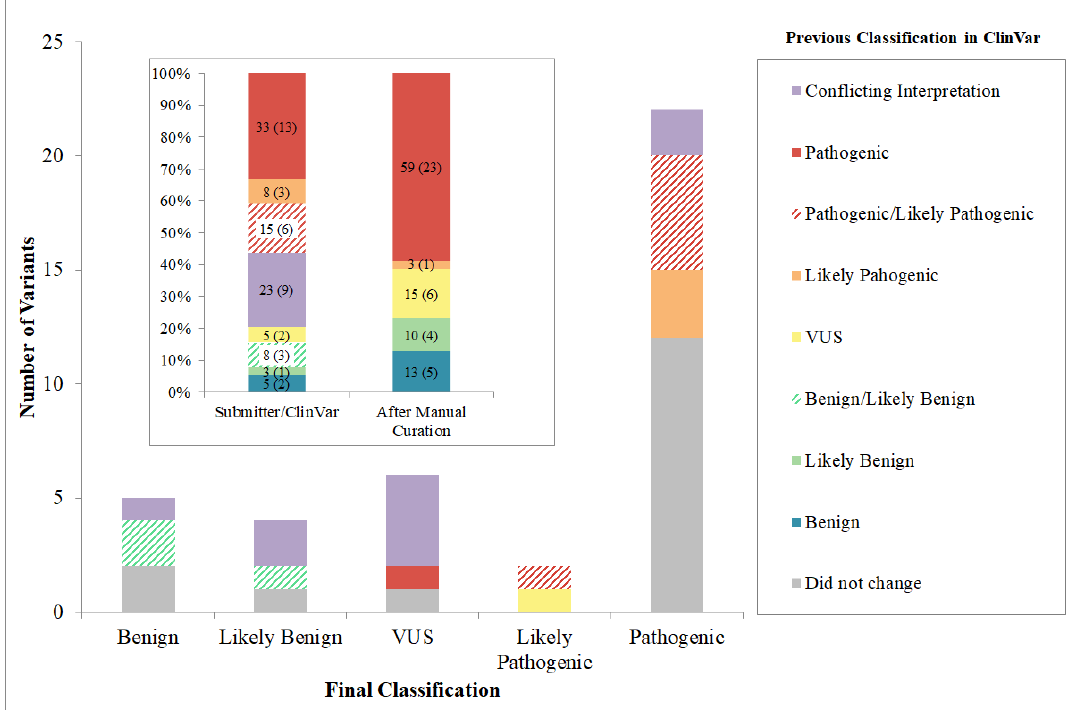
Figure 4. Final GJB 2 and GJB 6 variant classification. The height of each bar represents the number of variants for each classification. The colored segments of each bar represent previous classification in ClinVar. As a result of the curation process 59% of sequence variants changed their previous category submitted to ClinVar. The inner box shows the comparison of the 44 variant classifications between ClinVar submitters (from the original ACMG/AMP criteria) versus applying HL-EP specifications, demonstrating a reduction of “conflicting interpretation” and the increase of “pathogenic” categories. The number of variants for each interpretation is in brackets.